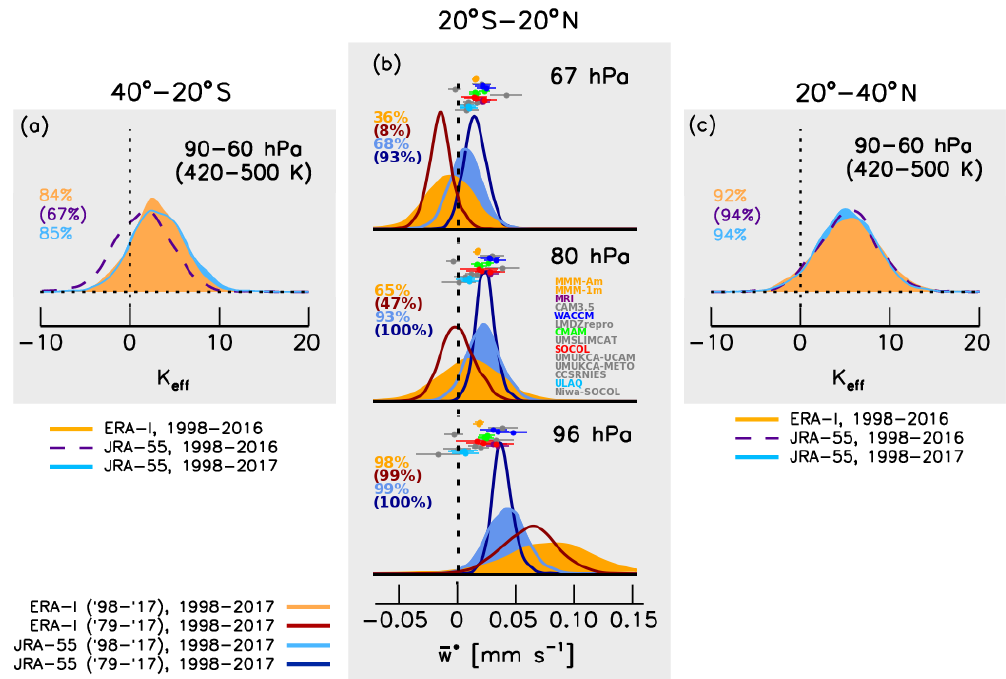
Figure 4. Effective latitudinal mixing and tropical upwelling changes since 1998. (a) Southern Hemisphere latitude- and pressure-averaged changes in latitudinal mixing, K eff (40–20 ◦ S); (c) as for (a) but for northern latitudes (20–40 ◦ N). (b) Tropical (20 ◦ N–20 ◦ S) upwelling changes ( w ∗ ) at three pressure levels: (top) 67hPa, (middle) 80hPa, and (bottom) 96hPa. Estimates are made from reanalysis for the periods in the legends; CCM estimates consider data over 1985–2017 with 1 σ error bars. In (b) , solid probability distribution functions (PDFs) are for changes estimated using data covering 1998–2017, while line PDFs use 1979–2017. For (a) and (c) ERA-Interim has a solid PDF for 1998–2016, while JRA-55 has a solid (line) PDF for 1998–2017 (1998–2016). Percentages represent the probability of positive changes in all PDFs; brackets surround percentages for the line PDFs. Time series for (b) are provided in Fig. S8; they are in Fig. S9 for (a, c)